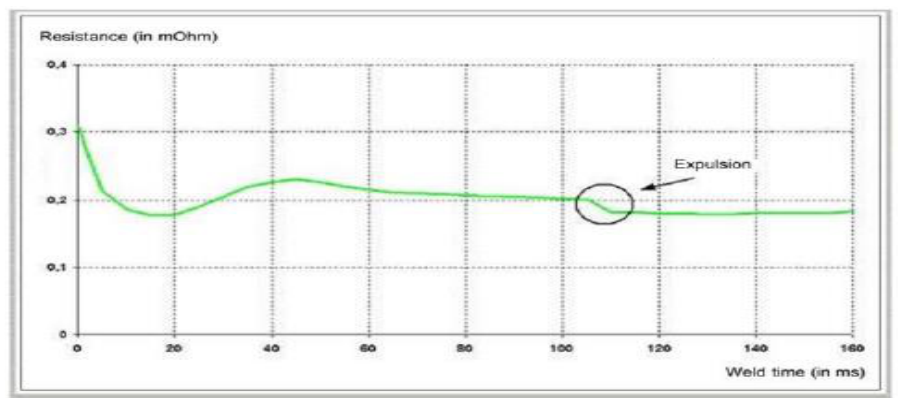
Figure 5. Resistance and weld time relationship.